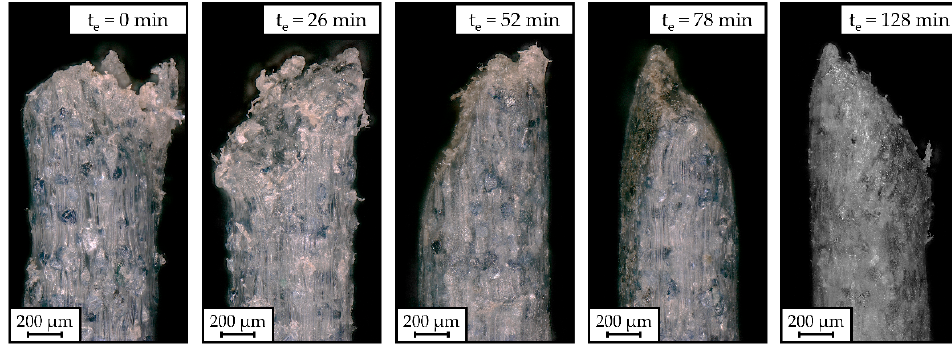
Figure 10. Microscopies of single filaments (S240x0.75) after different process times.